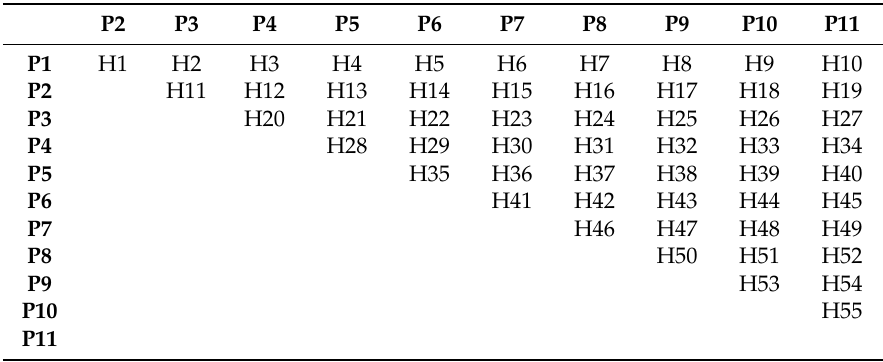
Table 1. Representation of the cross or hybrid combinations (55 in total) developed as a result of the half-diallel mating